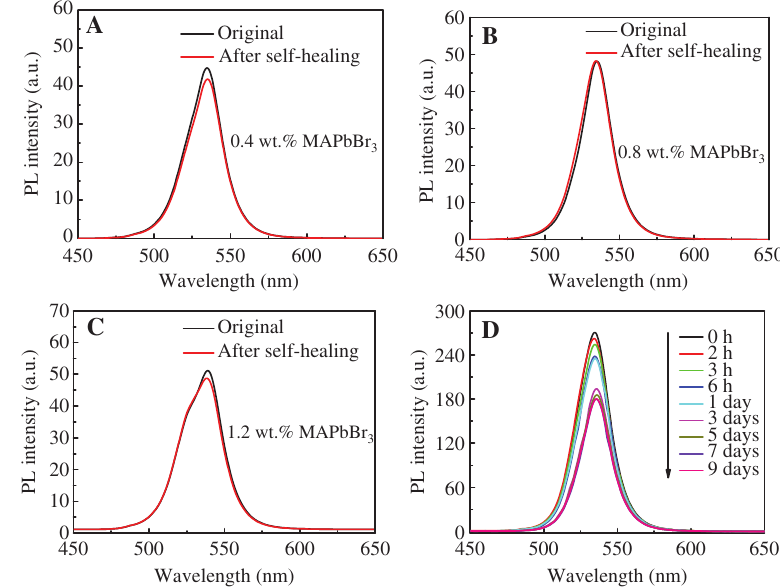
/PDMS-urea gels with different MAPbBr NC loading ratios before and after self-healing. Figure 4: The PL spectra of MAPbBr 3 3 (A) 0.4 wt.% of MAPbBr NCs; (B) 0.8 wt.% of MAPbBr NCs and (C) 1.2 wt.% of MAPbBr NCs. (D) Evaluation of the PL stability of the MAPbBr 3 3 3 (0.8 wt.%)/PDMS-urea gel by immersing the gel into water at room